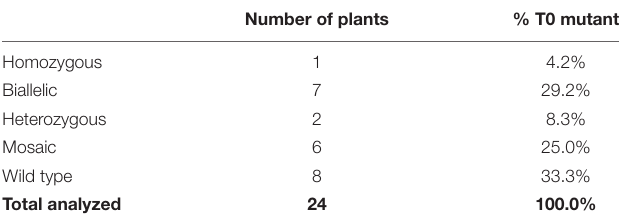
TABLE 5 | Summary of T0 mutant genotypes.* Number of plants % T0